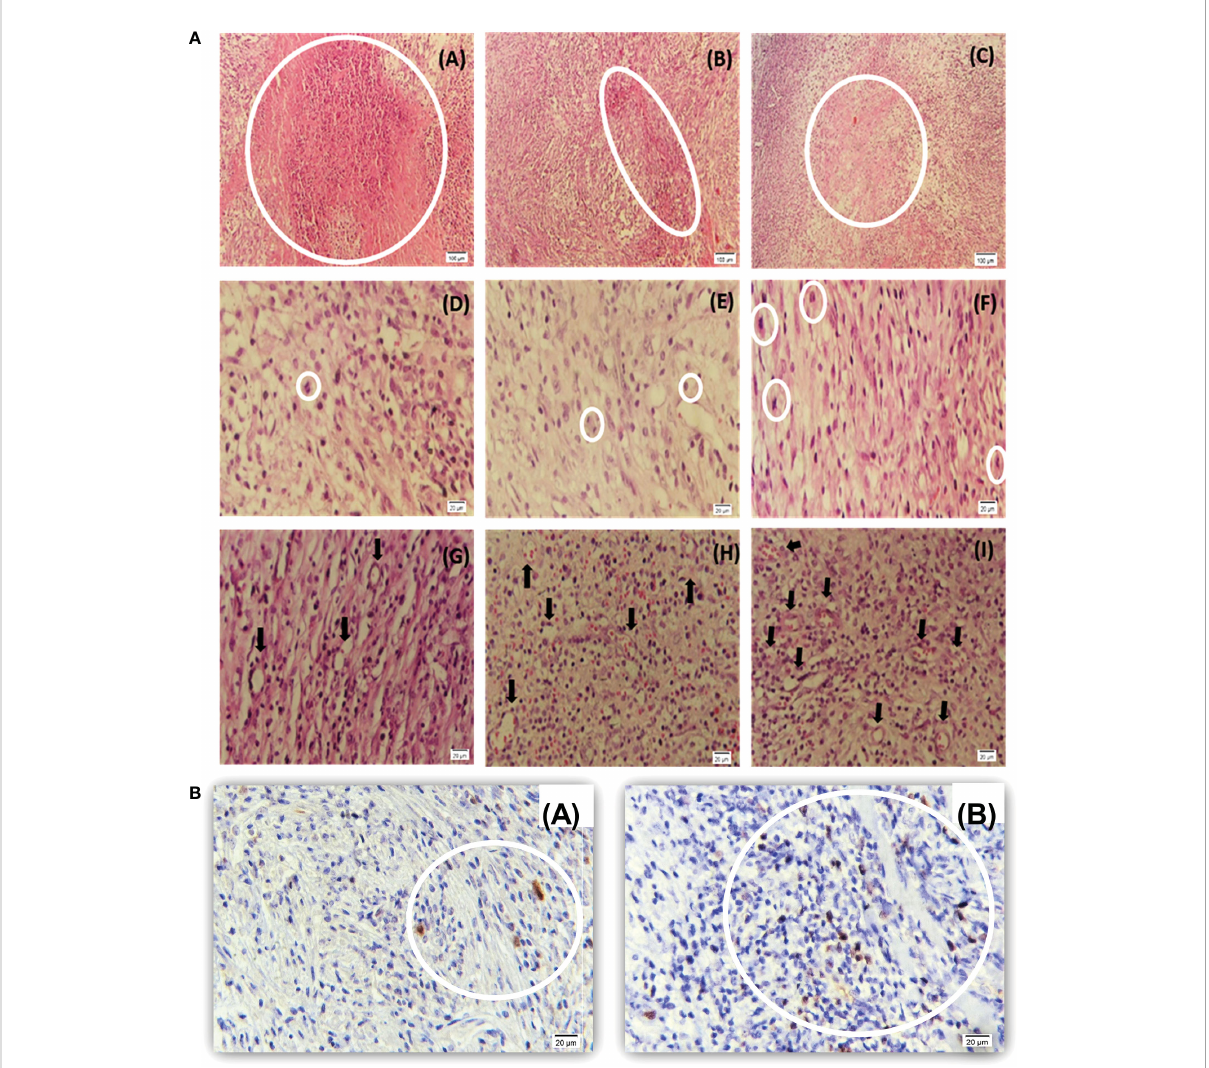
FIGURE 8 (a) Histopathology of LA7-induced tumors. (A – C) Higher necrotic area in 96 h-SPS – treated tumors (A) compared with the RPMI (B) and normal saline groups (C) . (D – F) The mitotic cell number was reduced in 96 h-SPS – treated tumors (D) in comparison with RPMI (E) and normal saline (F) groups. (G – I) Angiogenesis in three indicated groups. 96 h-SPS – treated tumors exhibited the lowest level of angiogenesis (G) when compared with the RPMI (H) or normal saline control (I) . *The magni fi cation of images: (A – C) 10X, (D – I) 40X. (b) Ki67 immunostained tumor – induced by LA7 cells. (A) Ki67-positive cells in the tumor treated with 96 h-SPS. (B) More Ki67-positive cells were observed in the tumor treated with normal saline in comparison with 96 h-SPS solution. *The magni fi cation of images: (A, B)